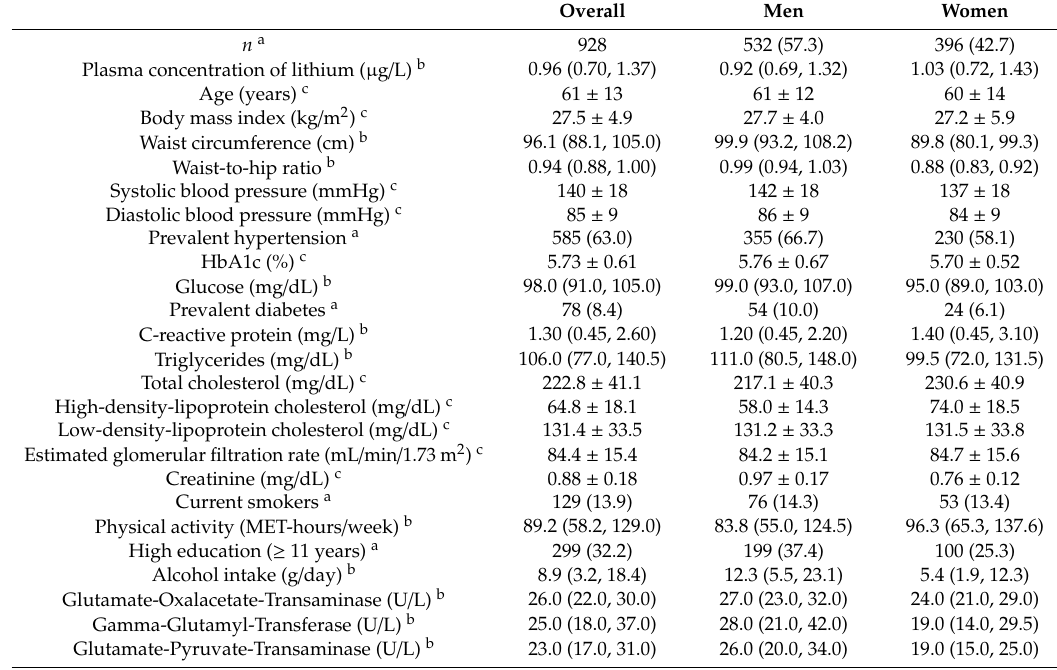
Table 1. General characteristics of the overall study sample and stratified by men and women.